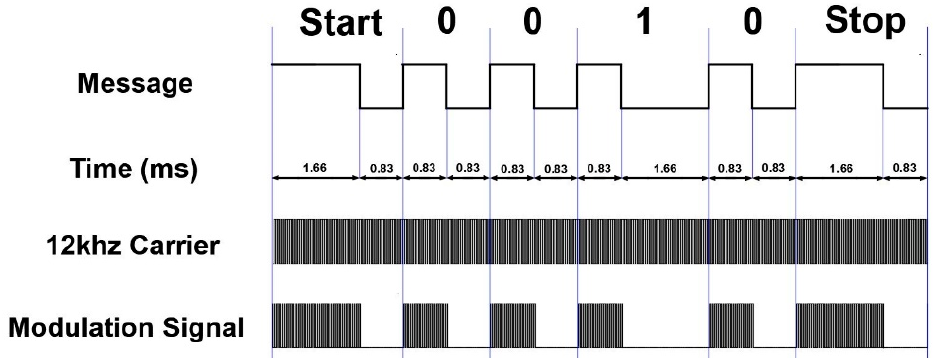
Figure 7. The composition and generation process of the modulated signal.